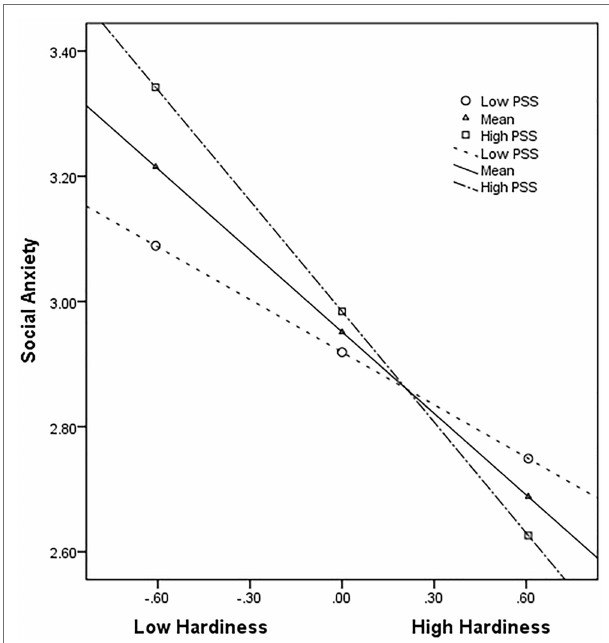
FIGURE 2 | Moderating effect of perceived social support (PSS) on the relationship between hardiness and social anxiety; the moderating effect is plotted for two levels of PSS: high PSS (1 SD above the mean) and low PSS (1 SD below the mean).